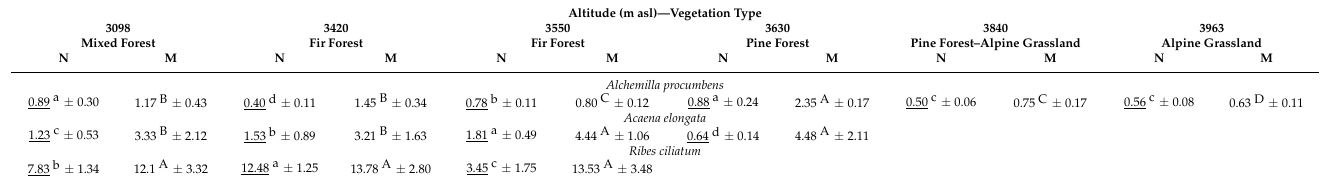
Table 2. Mean and standard deviation of leaf area produced during the rainy season (May, M), which corresponds to first leaves fully expanded, and leaves produced during the dry season (November, N), which developed at the start of dormancy along the altitudinal gradient. Underline mean for each pair within each altitude per species indicates differences found in the Student’s t -test. Capital letters indicate significance ( p < 0.05) for leaf development in May; lower case letters indicate significance ( p < 0.05) for the area of leaves that developed at the start of